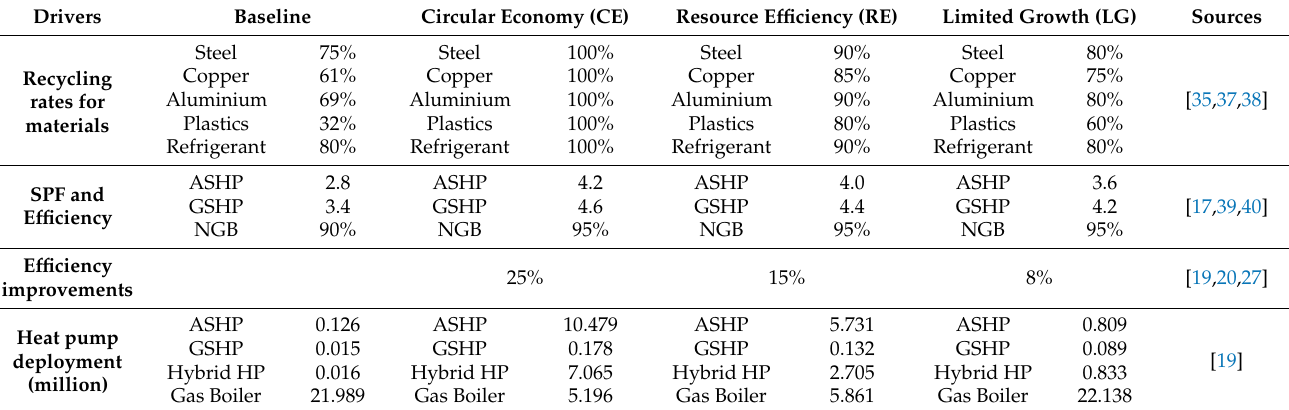
Table 4. Summary of system specifications and assumptions for